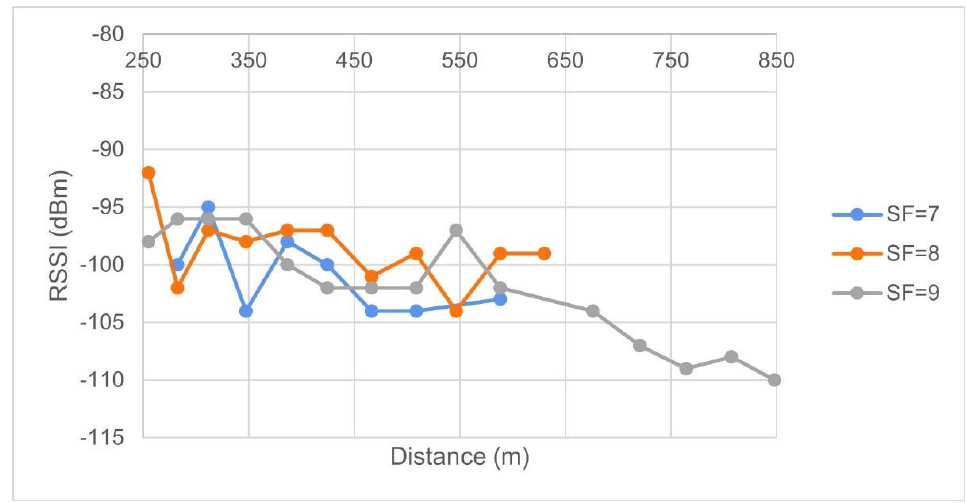
Figure 12. RSSI versus distance with bandwidth (BW) = 125 kHz and CR = 4/5, in Experiment 4.